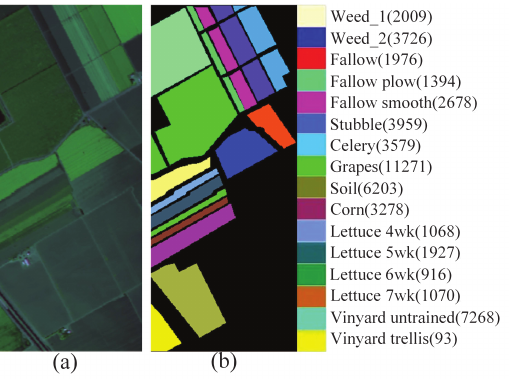
Figure 6. Salinas hyperspectral image. ( a ) False-color image. ( b ) Ground-truth map.